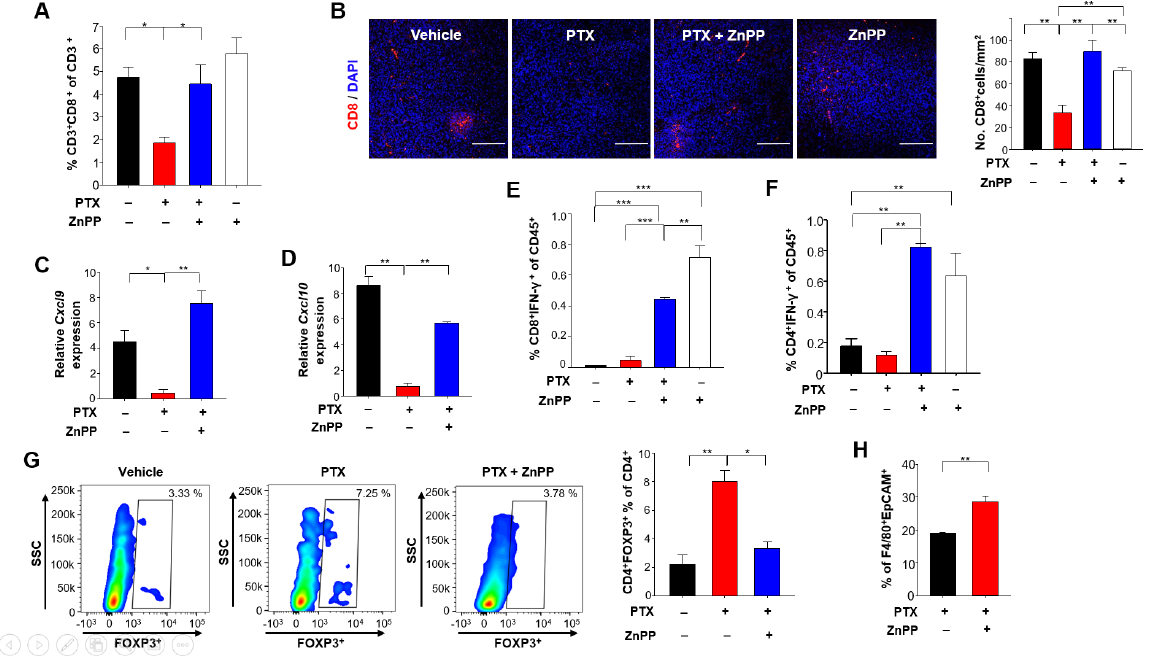
Figure 6. Effects of HO-1 inhibition on T cell-mediated anti-tumor immunity in 4T1-tumor bearing mice under PTX therapy. ( A ) CD45 + CD3 + CD8 + tumor-infiltrating lymphocyte populations (as percentages) were identified by flow cytometry. ( B )